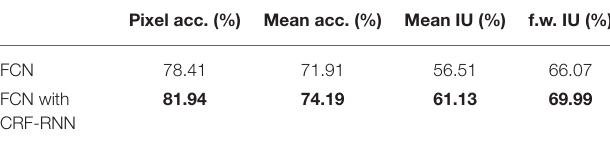
TABLE 3 | The overall performance of material segmentation on the MINC dataset.